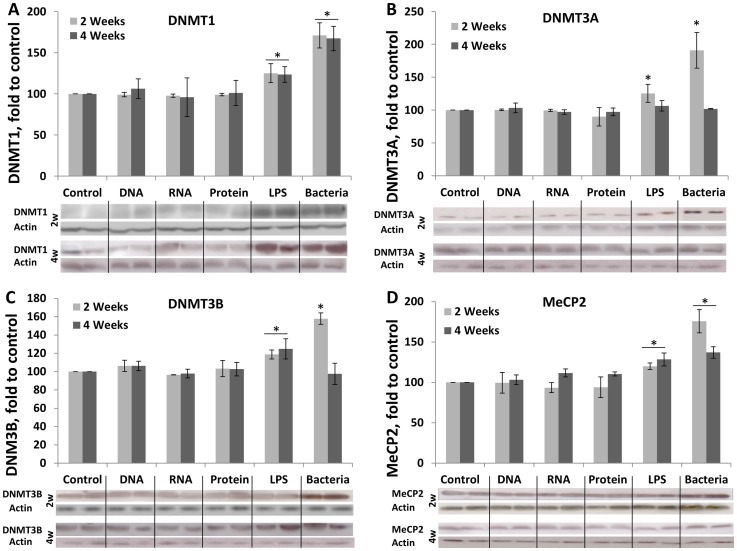
Western blot analysis of DNMT1 (A), DNMT3A (B), DNMT3B (C) and MeCP2 (D) protein levels in liver tissue of mice exposed to whole heat-killed E. coli O157:H7 bacteria and DNA, RNA, protein, and LPS extracted from heat-killed bacteria.Bars show the average protein levels (with SD) as compared to the control set at 100%. Asterisks and bars show significant increase from non-exposed controls through the analysis of data using one way ANOVA test (p<0.05). Lower panel shows representative Western blots in 2 and 4 weeks groups.